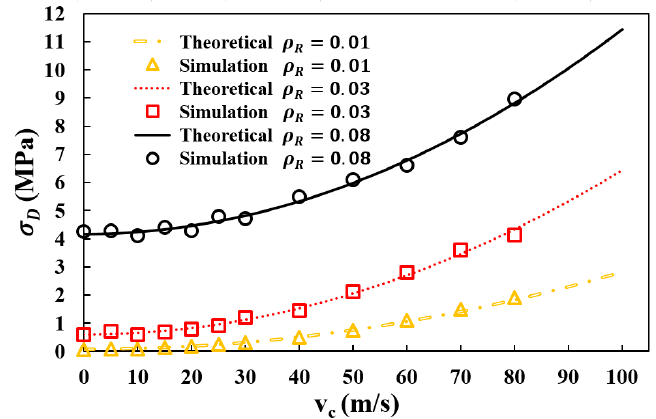
Figure 11. The Dynamic plateau stress σ D from numerical simulation and theoretical prediction using Equation (6).